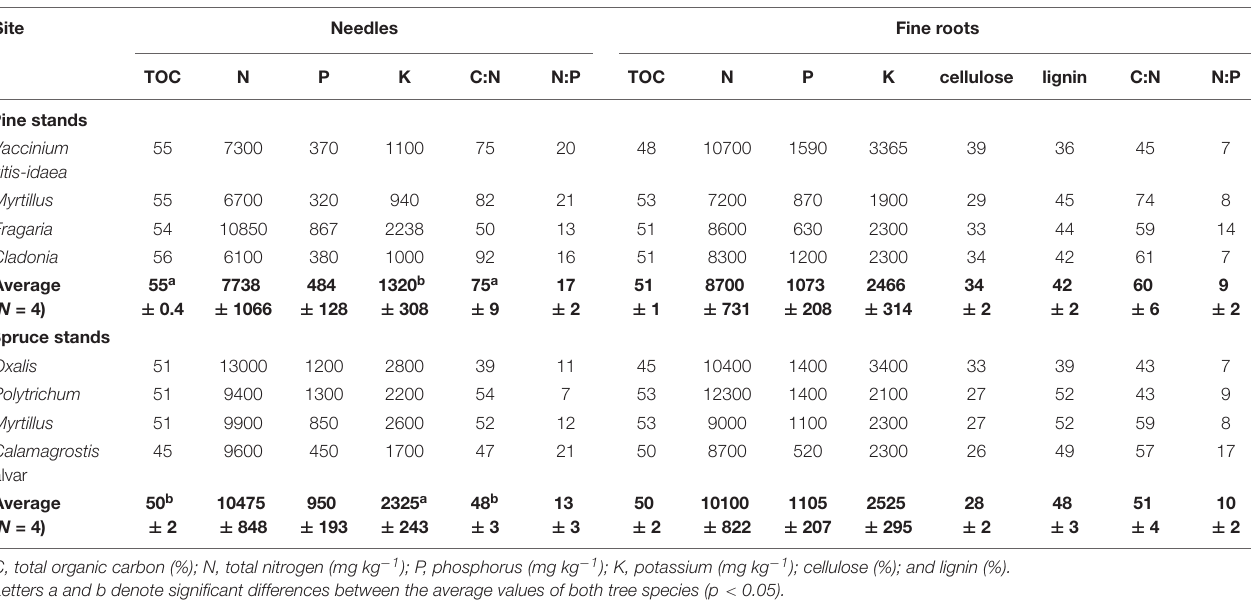
TABLE 2 | Chemical composition ( ± standard error) of the incubated needles and fine roots.